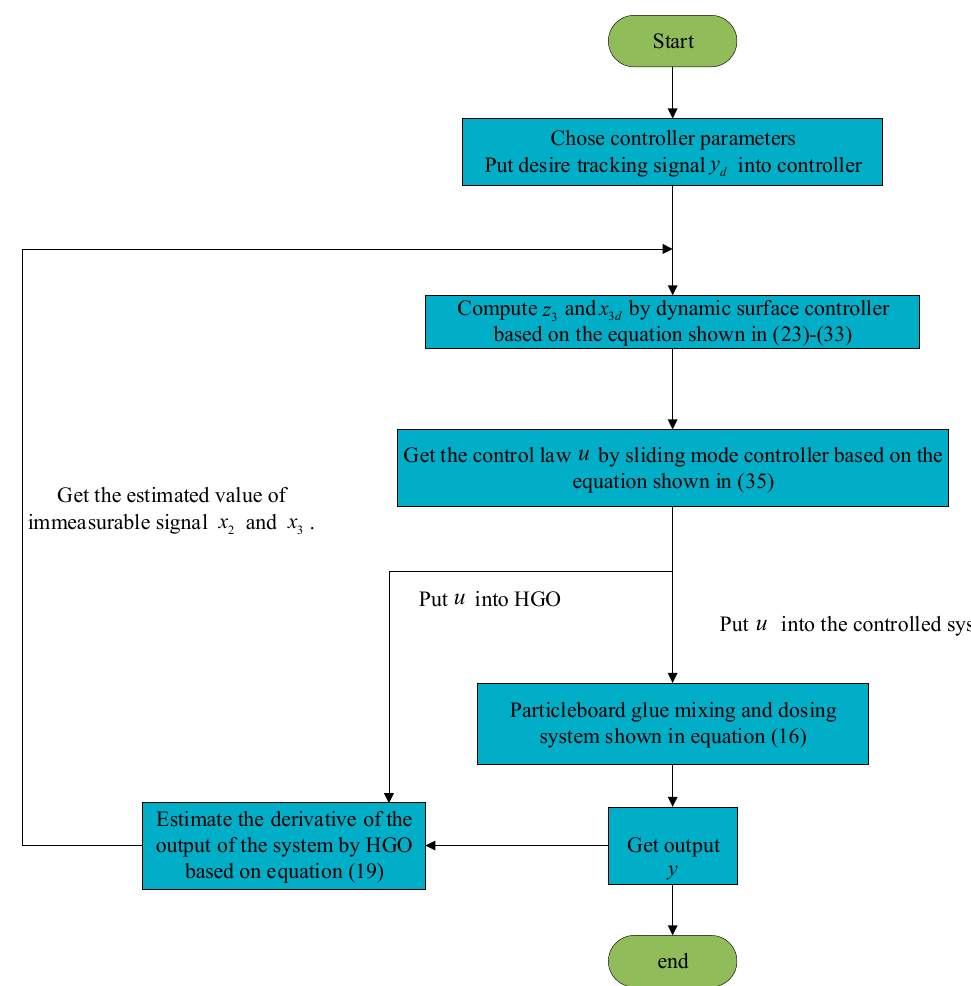
Figure 4. Flowchart of the proposed control algorithm.